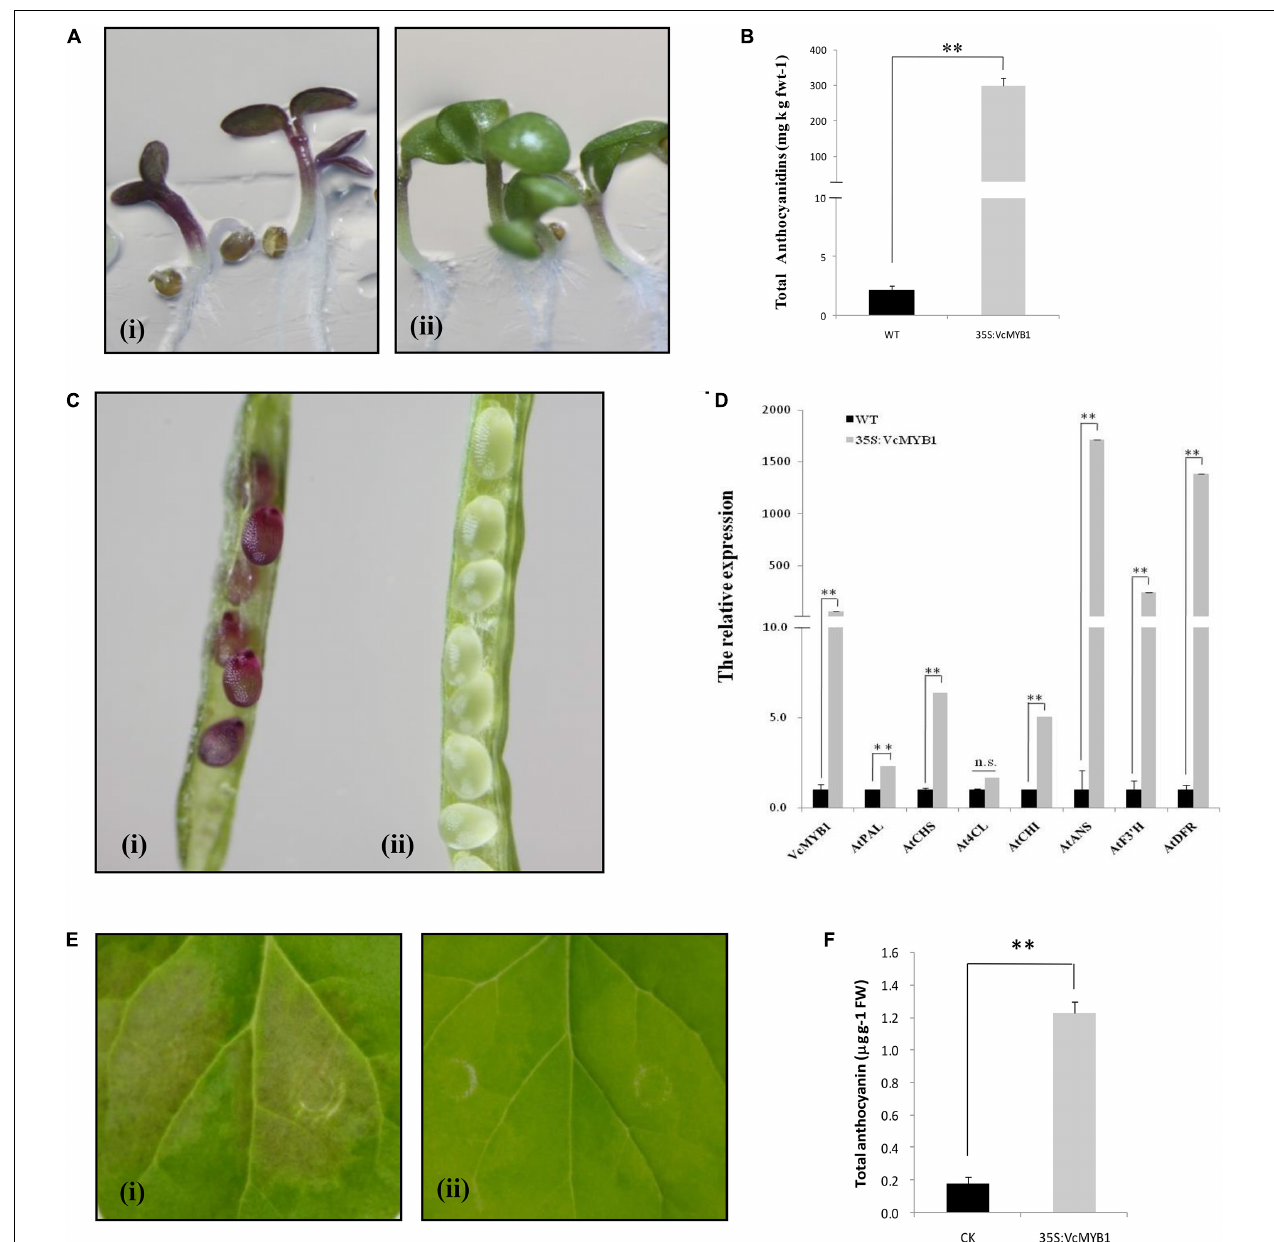
FIGURE 4 | Functional analysis of VcMYB1 in a heterologous system. (A) Arabidopsis thaliana (ecotype Columbia) plants overexpressing (i) 35S:VcMYB1 and (ii) wild-type (WT) A. thaliana . (B) Anthocyanin content of A. thaliana plants overexpressing 35S:VcMYB1 and wild-type A. thaliana . Asterisks denote t -test significance: ∗∗ P < 0.01. The mean ± SE of biological triplicates were taken for every value. (C) Seeds of A. thaliana plants overexpressing (i) 35S:VcMYB1 and (ii) WT A. thaliana . (D) Relative expression of VcMYB1, AtPAL, AtCHS, At4CL, AtCHI, AtANS, AtF3 (cid:48) H, and AtDFR in A. thaliana plants overexpressing 35S:VcMYB1 and wild-type A. thaliana . All values were calculated based on the housekeeping gene AtUBQ . Asterisks denote t- test significance: ∗∗ P < 0.01. n.s means no significant differences. The mean ± SE of biological triplicates were taken for every value. (A,C) Are one of the four T2 transgenic stains and all strains exhibit the phenotype shown by (A,C) . (E) Tobacco ( Nicotiana benthamiana ) leaves on day 7 after injection. (i) 35S:VcMYB1, (ii) Wild-type. (F) Anthocyanin content in tobacco leaves on Day 7 after injection. The mean ± SE of biological triplicates were taken for every value. Asterisks denote t -test significance: ∗∗ P < 0.01.